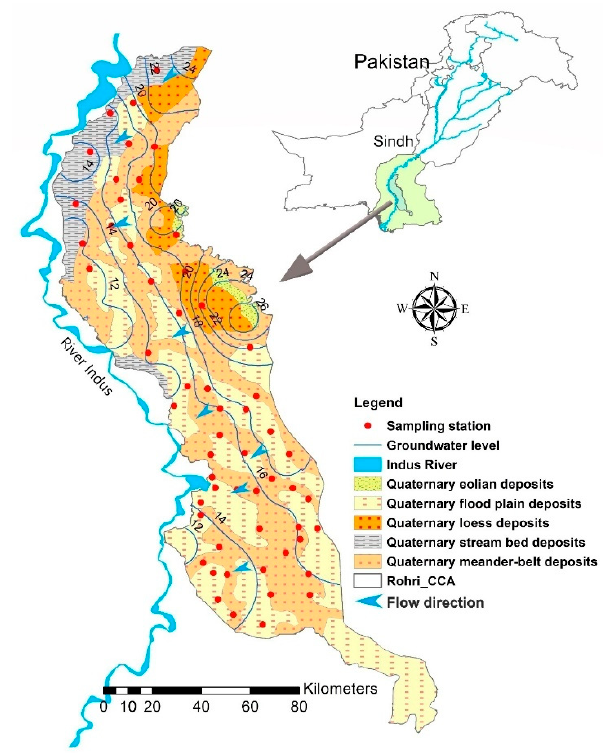
Figure 1. Location of the study area and sampling stations (Rohri Canal Command).